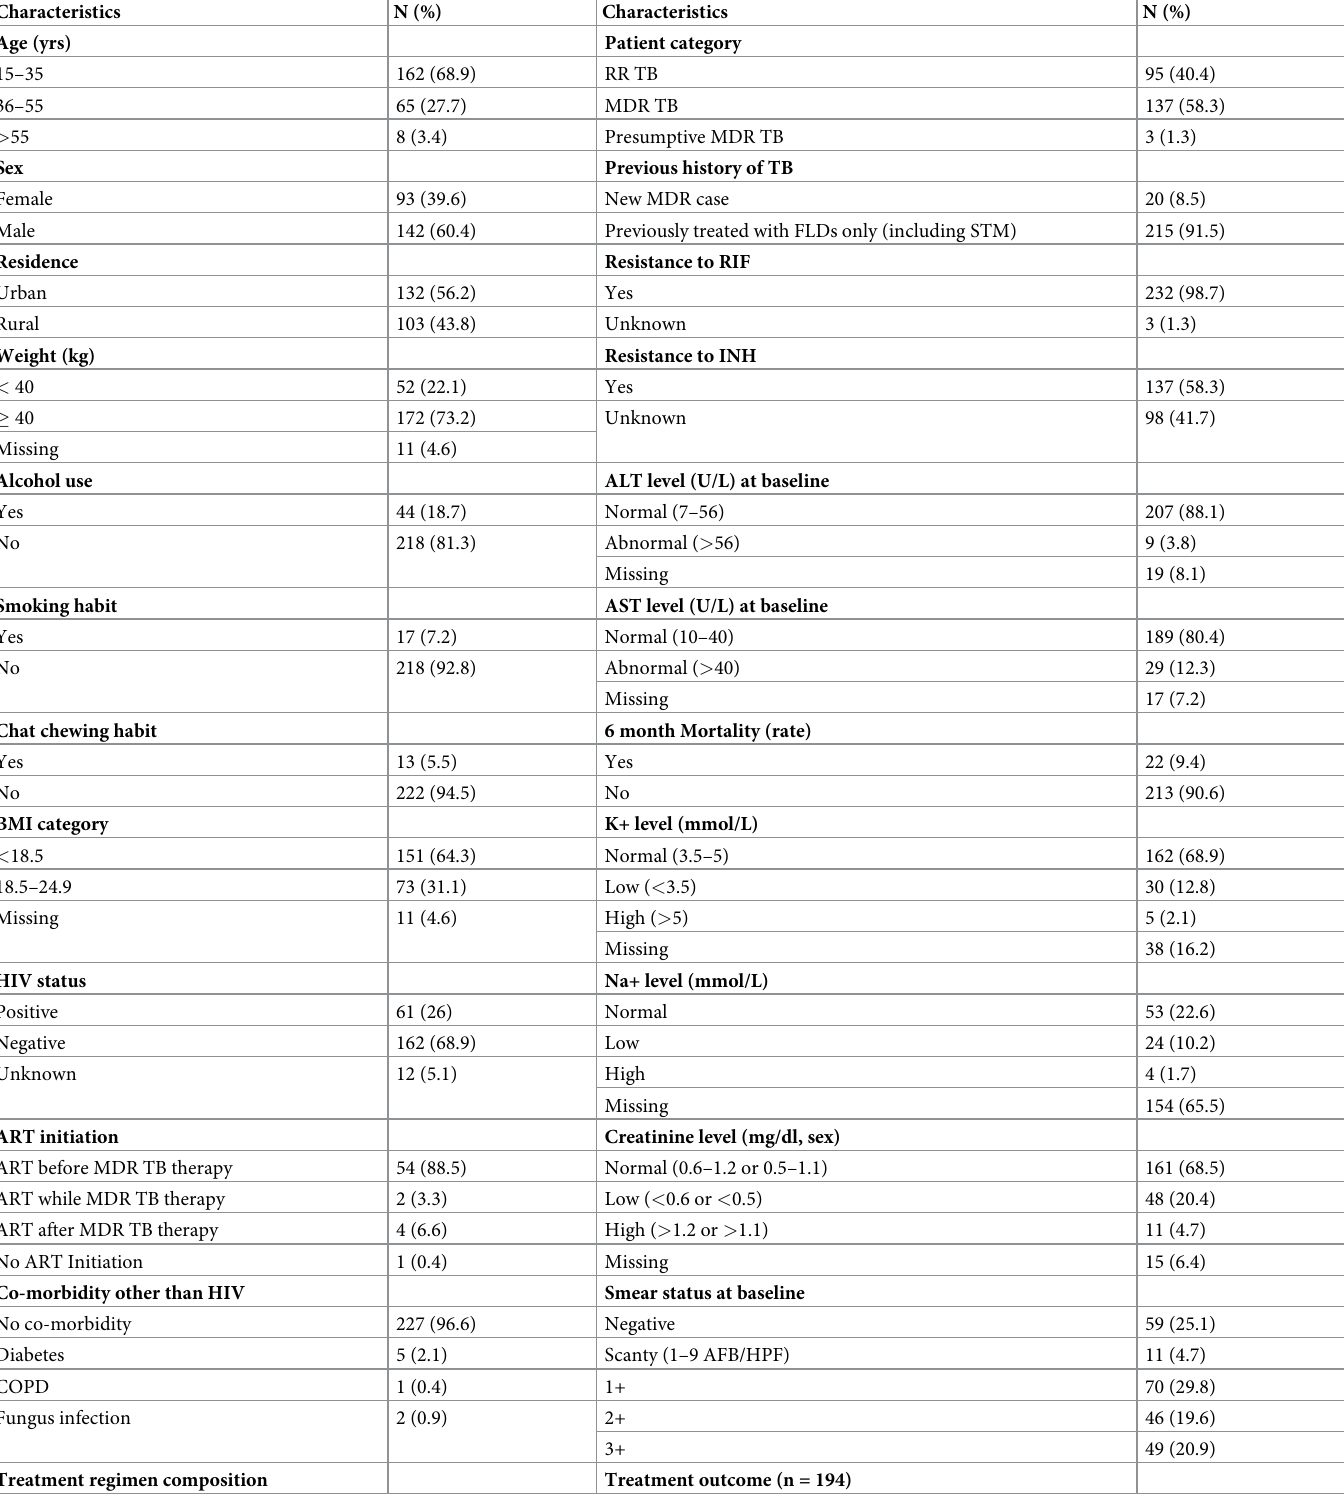
Table 1. Demographic, clinical and microbiological characteristics of multi-drug resistant tuberculosis patients.